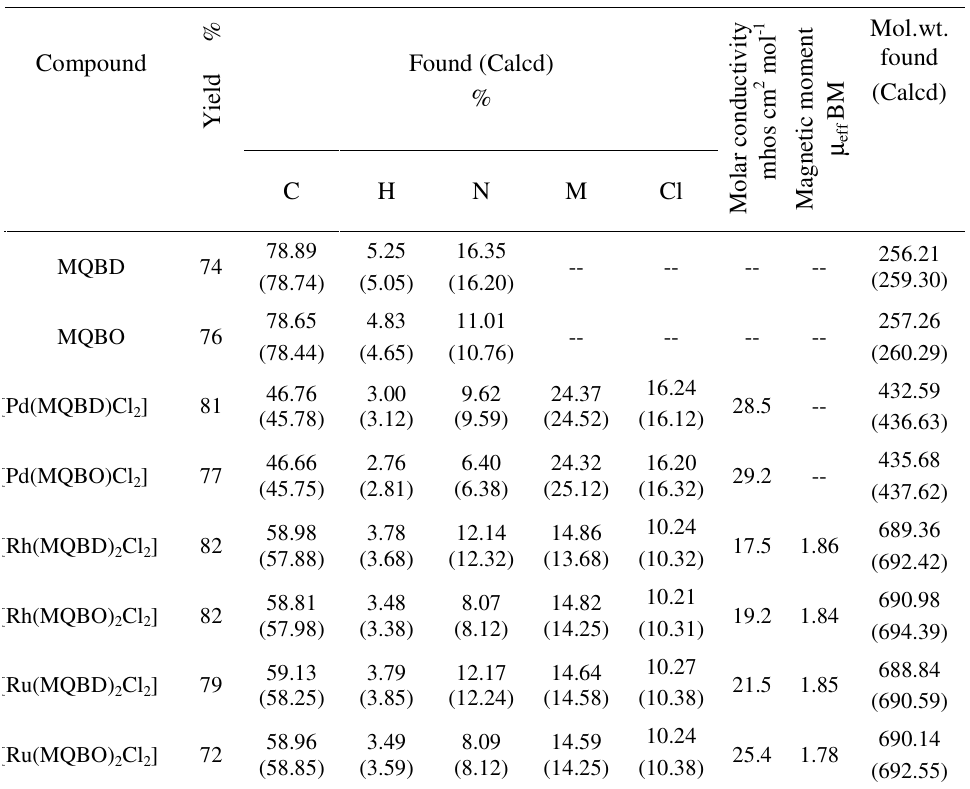
Table 1 . Physical constants of ligands and its